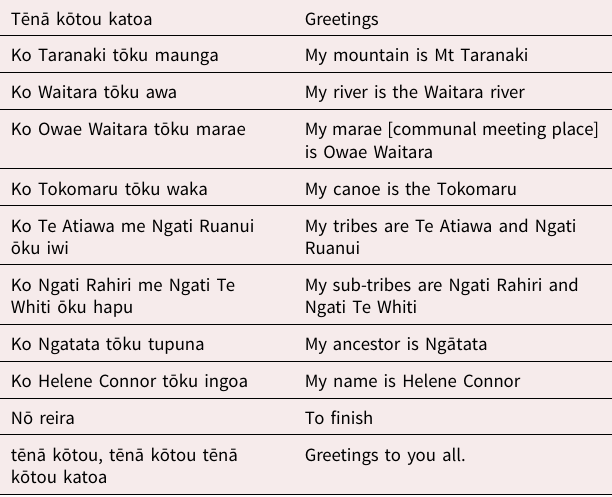
Table 2. Pepeha (M ā ori Device for Introducing the Self) of Helene Connor T ē n ā k ō tou